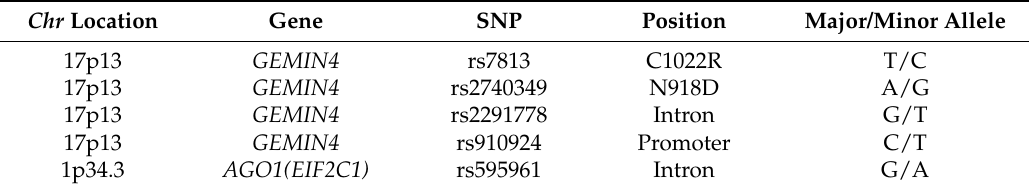
Table 2. Single nucleotide polymorphisms in microRNA biogenesis